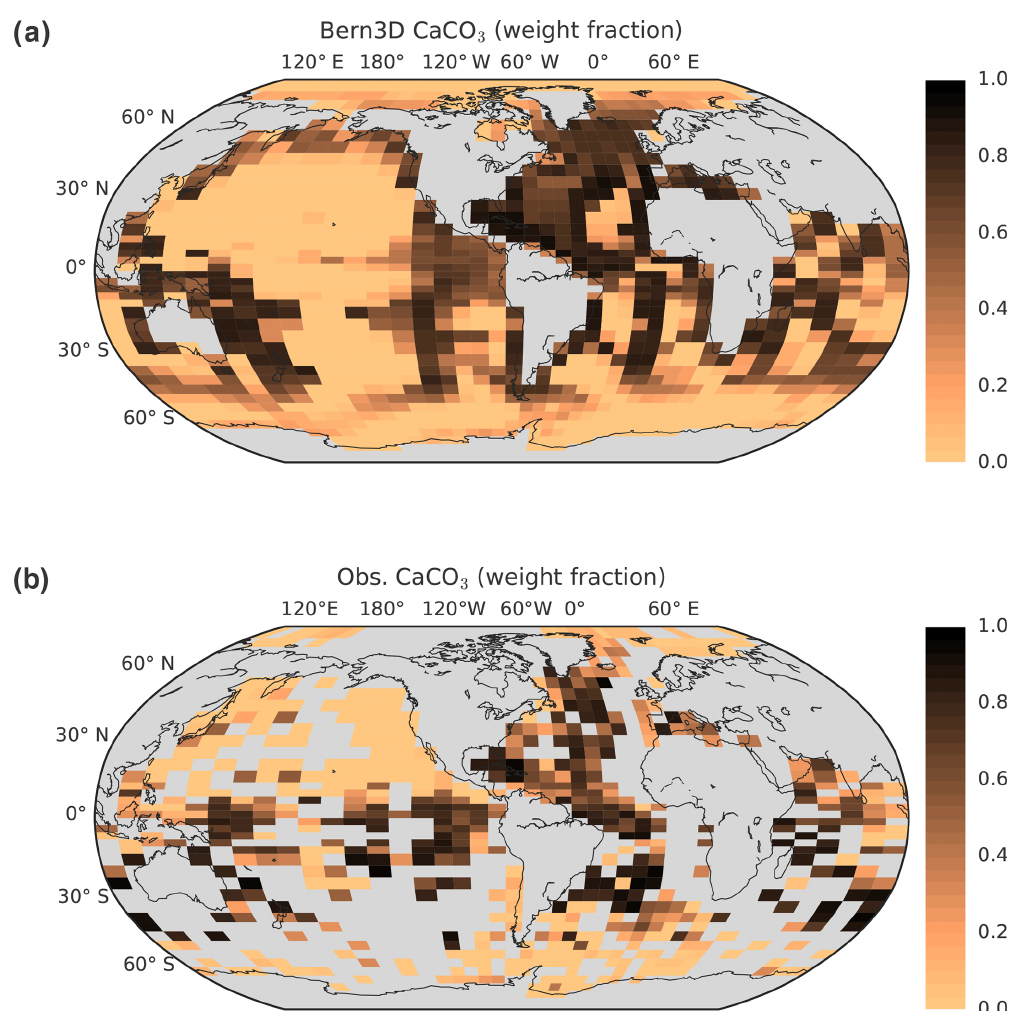
Figure B1. (a) Distribution of CaCO 3 in the Bern3D model after tuning of the sediment component under preindustrial boundary conditions compared to (b) sediment core-top CaCO 3 data (Cartapanis et al., 2018). Core-top data were gridded onto the Bern3D grid and are a mean of the top 10cm over the past 6kyr. Grey indicates land (within coastlines) or missing